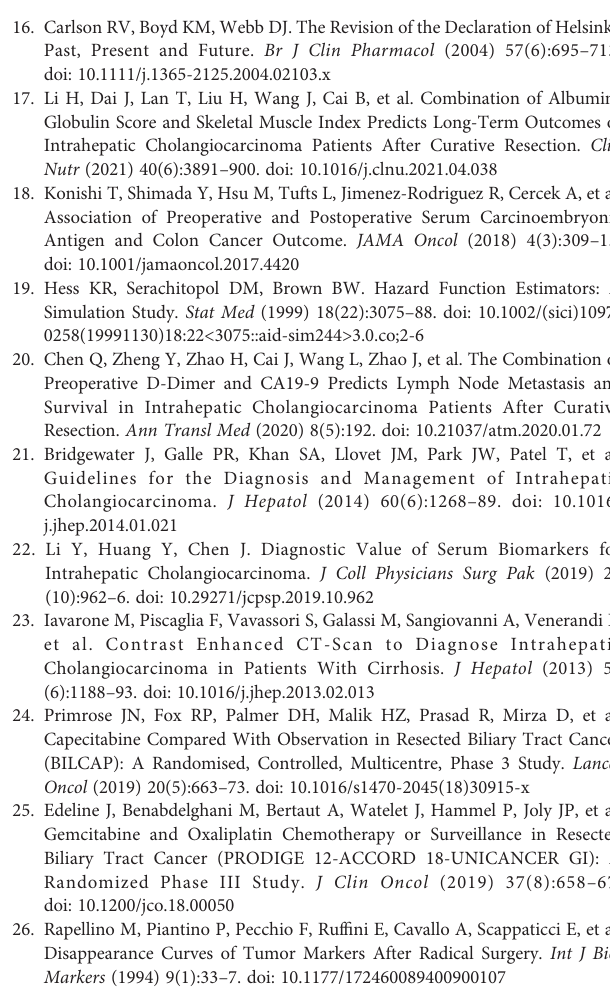
Supplementary Figure S2 | Kaplan-Meier curves showing long-term survival of patients treated with adjuvant chemotherapy or not. (A) , recurrence-free survival. (B) , overall survival. Supplementary Figure S3 | Long-term survival by preoperative and postoperativeCA19-9levelsusingone-monthastimepointforpostoperativetestof CA19-9. (A) , recurrence-free survival of patients with normal preoperative versus normalized or persistently elevated postoperative CA19-9. (B) , overall survival of